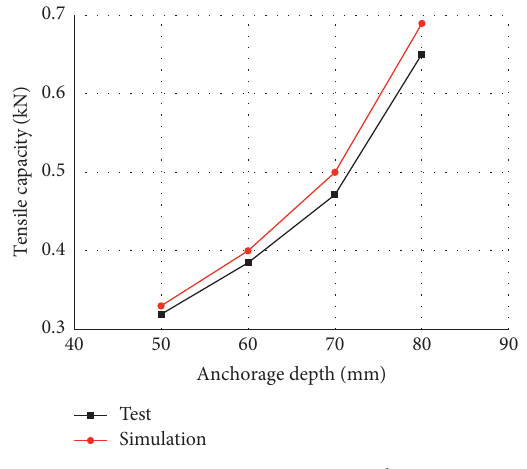
Figure 13: Data comparison